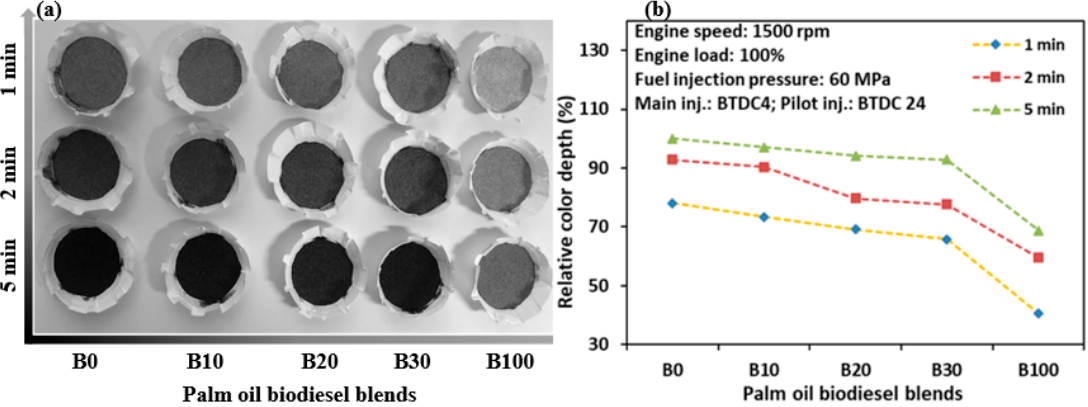
Figure 6. Effect of engine loads on ( a ) CO, ( b ) hydrocarbon (HC), and ( c ) nitrogen oxide (NOx) emissions and ( d ) smoke opacity.